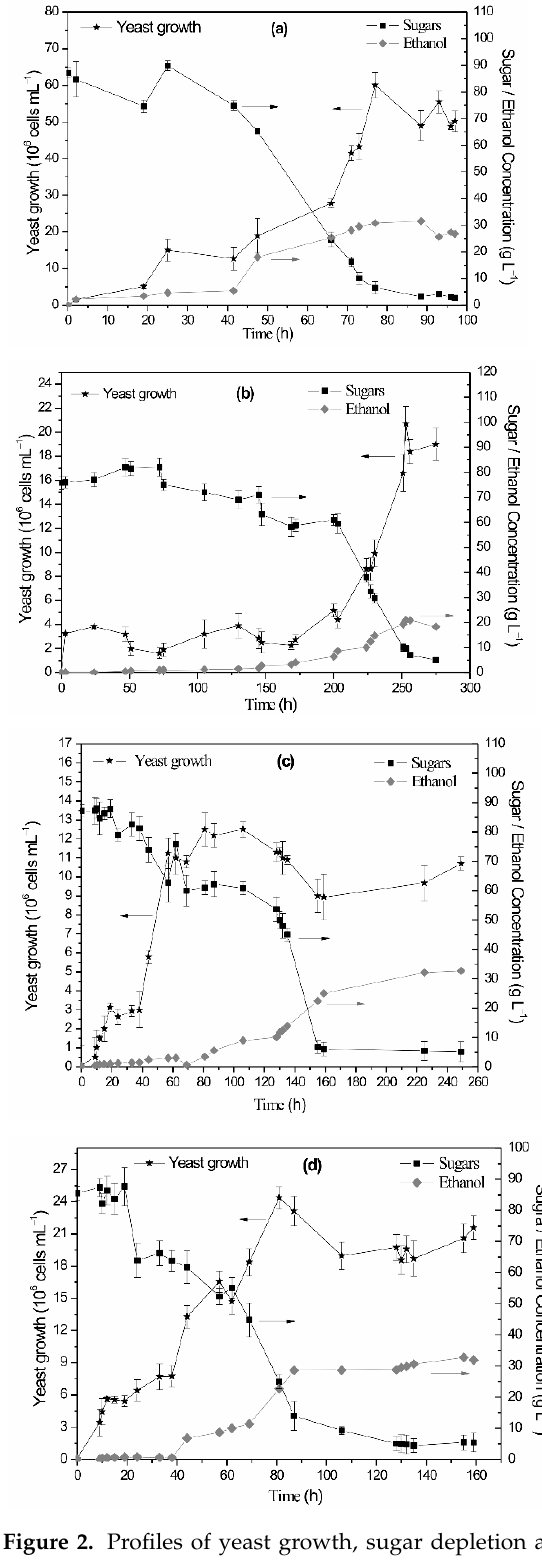
Figure 2. Profiles of yeast growth, sugar depletion and ethanol production through time using cyanobacterial-based biomass grown on: ( a ) dairy wastewater treated with H 2 SO 4 at 120 min hydrolysis time, ( b ) winery wastewater treated with H 2 SO 4 at 120 min hydrolysis time, ( c ) mixed wastewater (winery and raisin) treated with H 2 SO 4 at 120 min hydrolysis time, and ( d ) mixed wastewater treated with H 2 SO 4 at 180 min hydrolysis time.